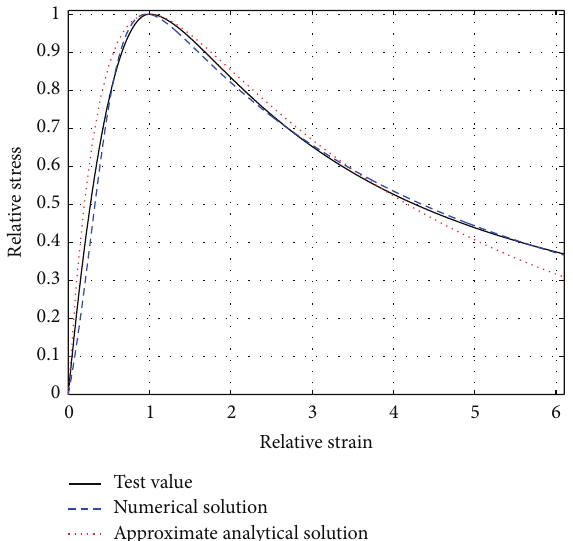
Figure 6: Constitutive curves for concrete based on SIR